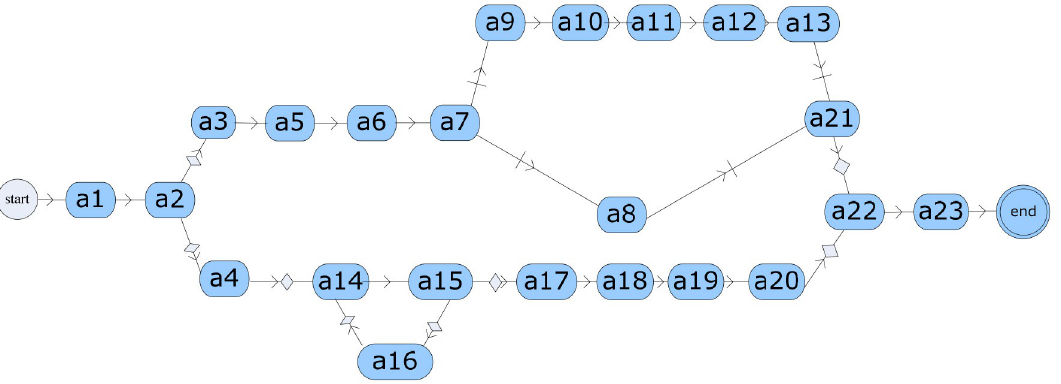
Figure 2. Business process model for mold project management